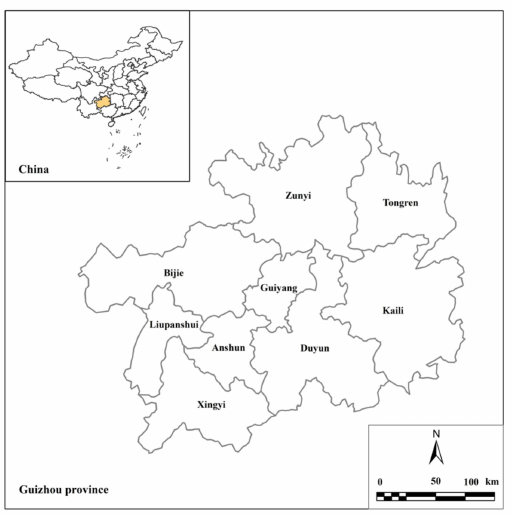
Figure 1. Location and administrative division of Guizhou